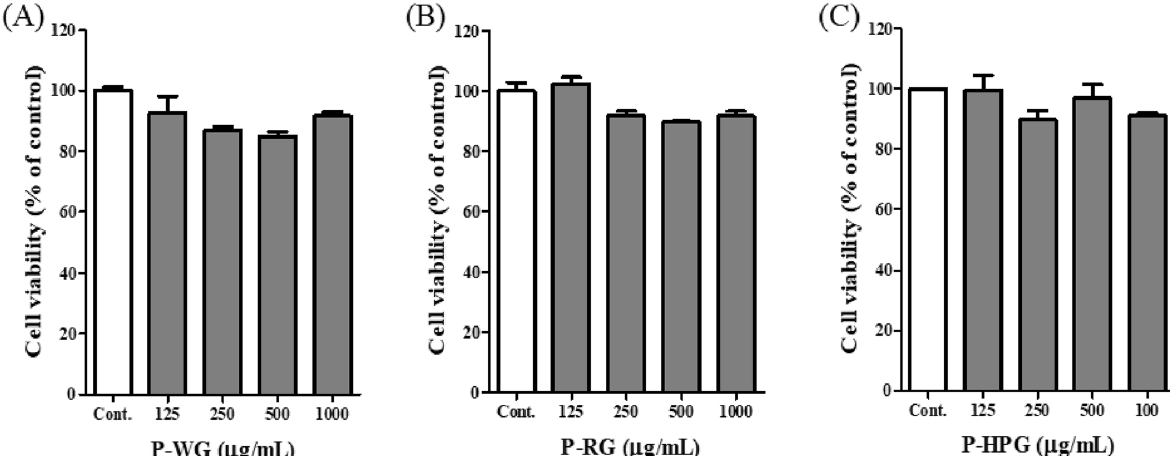
Fig. 5 Effects of P‑WG, P‑RG, and P‑HPG on the viability of RAW 264.7 cells. Cells were treated with either a P‑WG, b P‑RG, or c P‑HPG at concentration s of 125, 250, 500 or 1000 μg/mL. Cell viability was assessed using an EZ‑Cytox cell viability assay kit. All data are presented as mean standard deviation (SD), with n ± =